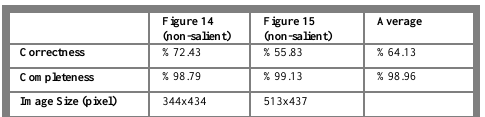
Table 7 : Evaluation of Ziplock Snake for non-salient roads